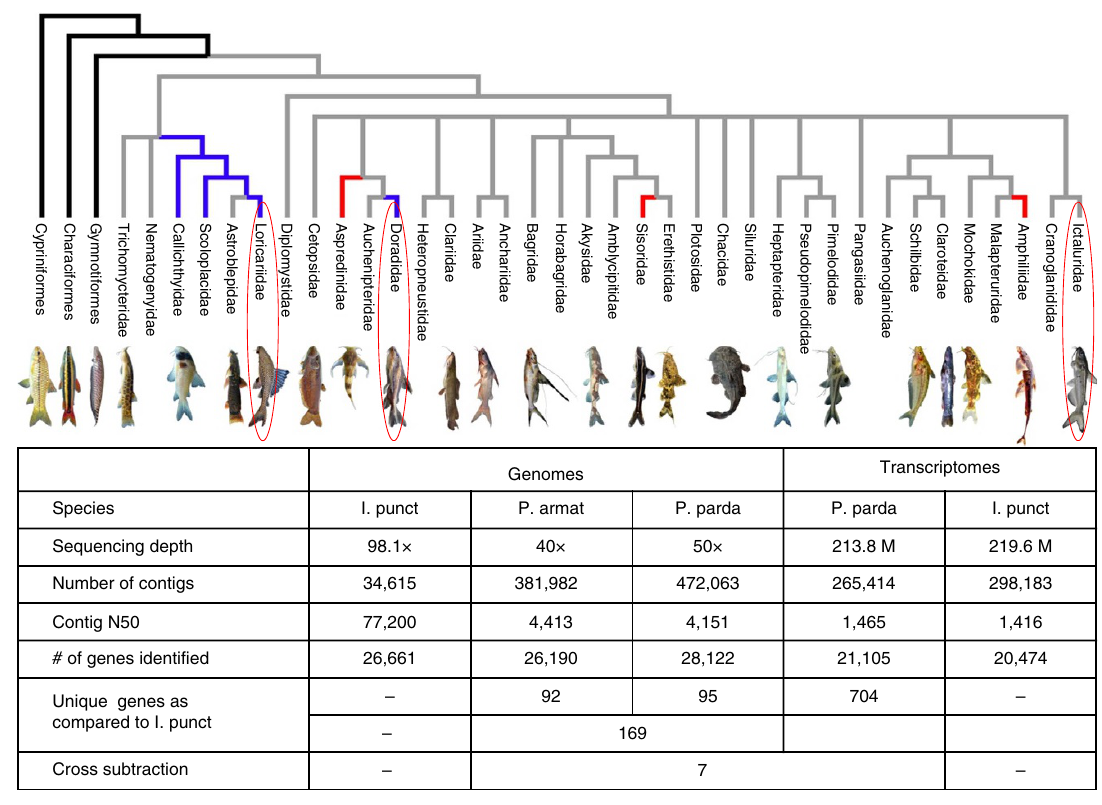
Figure 7 | Generation and analysis of genome and transcriptome sequences from scaled catfishes. Scales represent the primitive condition in the Otophysi (black branches), with catfishes lacking scales (grey branches). Bony plates have evolved several times within catfishes and include all members of the family (blue branches) or just some members of a family (red branches). It is unknown whether the plated condition within callicthyids, scoloplacids and loricariids is homologous. Phylogeny simplified from Sullivan et al. 6 . Photos by J.W. Armbruster, N.K. Lujan, M.H. Sabaj-Perez, S. Smith, K. Luckenbill, H.H. Ng, Z. Randall and L.M. Page. I. puntat, Ictaluras punctatus ; P. armat, Platydoras armatulus ; P. parda, Pterygoplichthys pardalis . The genes listed with ‘cross subtraction’ are the number of genes that were found and expressed in the genome of scale catfishes, but not present in the genome of scaleless channel